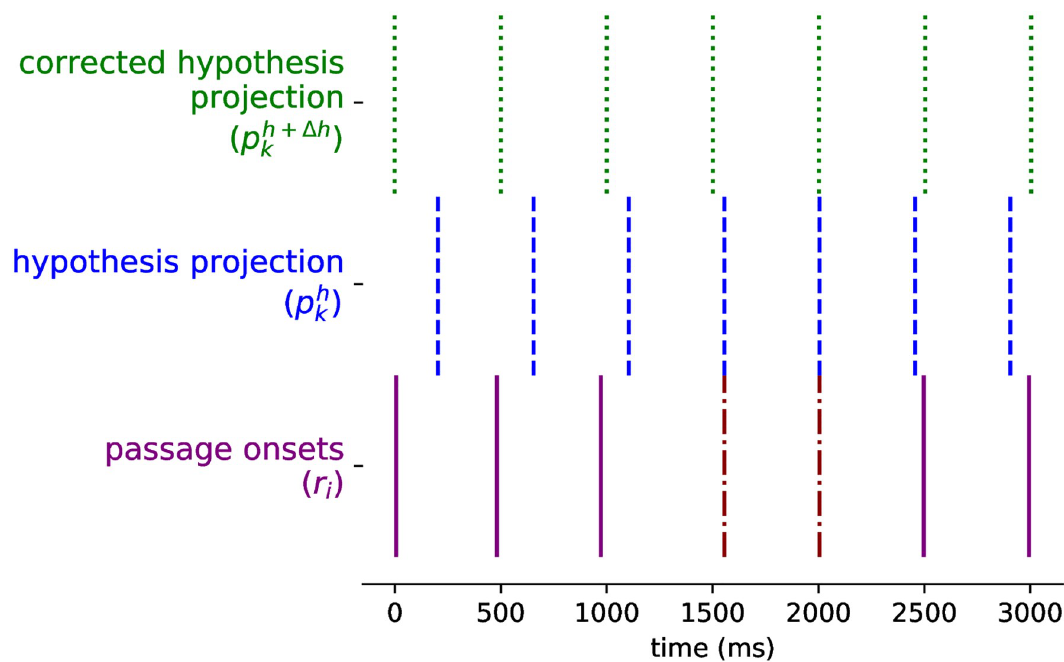
Fig 5. Example of how a hypothesis is corrected on a simple isochronous beat. From bottom to top: ( r i ) the rhythmic passage events with the onsets originating our tactus hypothesis marked differently, ð p h projection of the corrected